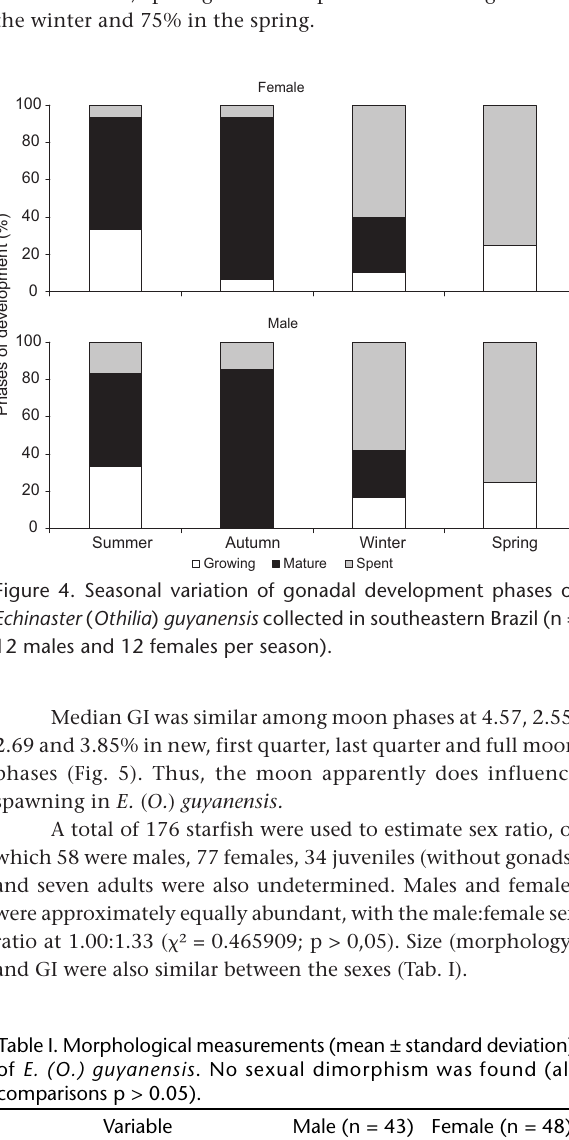
Figure 6. Median gonad index distribution (%) (upper error bar = 75% and lower error bar = 25%), relative frequency and relative frequency of animals with and without gonads of the several arm length class of Echinaster ( Othilia ) guyanensis collected in south- eastern coast of Brazil (n = 120; 54 males and 66